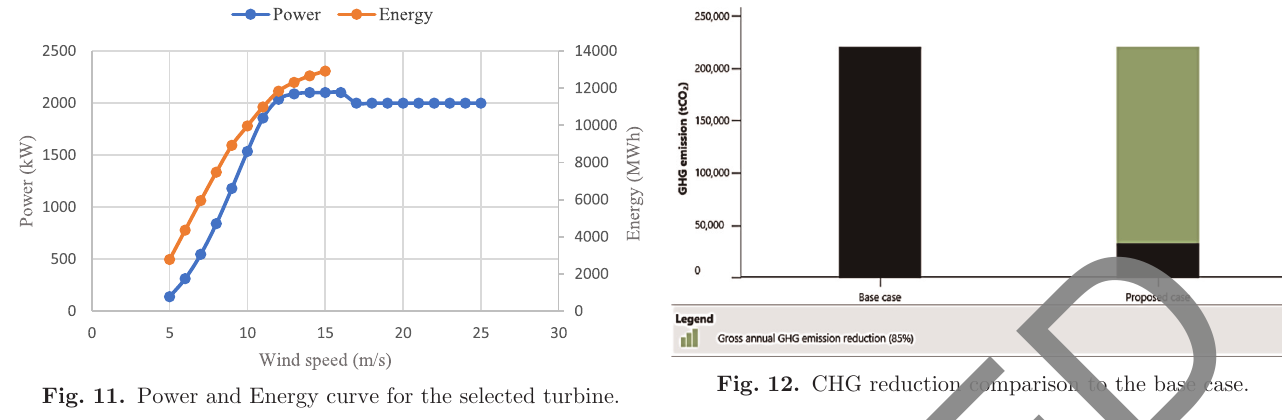
Fig. 11. Power and Energy curve for the selected turbine. Table 3. Technical speci fi cations of the turbines. Wind turbine parameter